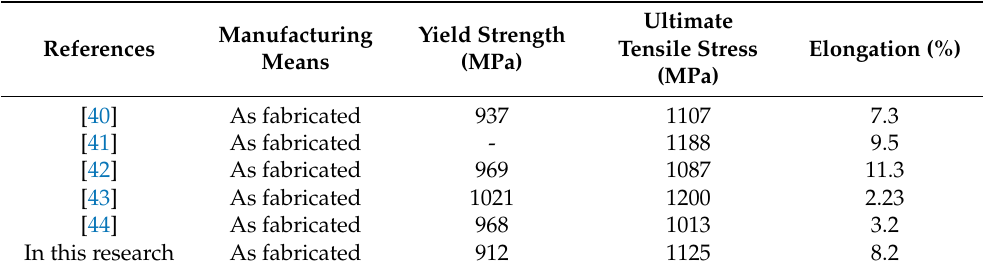
Figure 9. Tensile properties of L-PBF samples under different combinations of scanning strategies and a single scanning strategy. ( a ) Tensile properties of L-PBF samples under various combinations of scanning strategies; ( b ) tensile properties of L-PBF samples under angled offset scanning strategy; ( c ) tensile properties of L-PBF samples under general scanning strategy. Table 4. Some other experimental studies on the tensile properties of L-PBF-formed TC4 titanium alloy